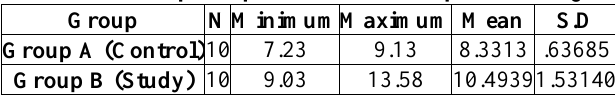
Table 1: Descriptive parameters of impact test Kj/m 2